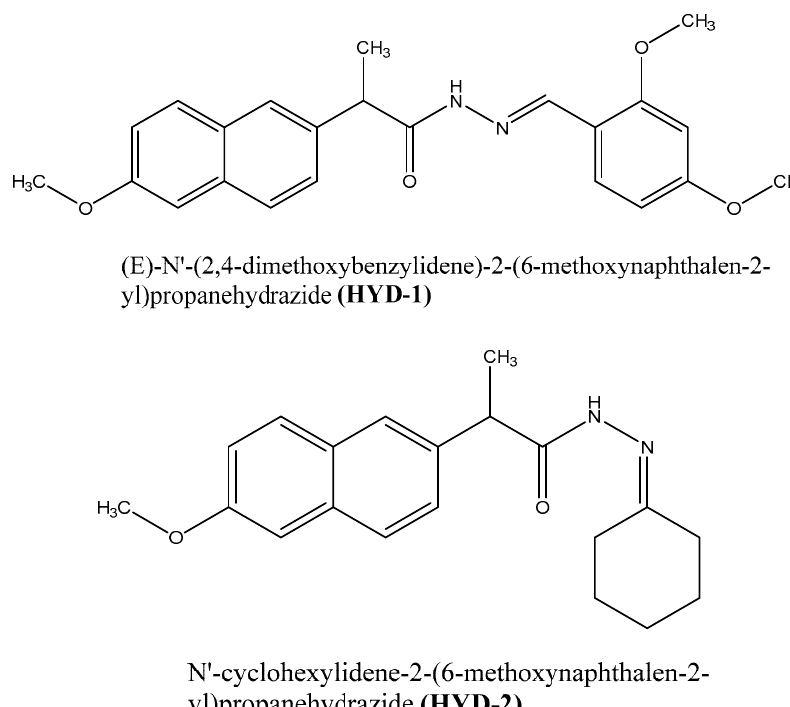
Figure 1. Molecular structures of (E)-N'-(2,4-dimethoxybenzylidene)-2-(6-methoxynaphthalen-2-yl) propanehydrazide ( HYD-1) and N'-cyclohexylidene-2-(6-methoxynaphthalen-2-yl) propanehydrazide (HYD-2) .